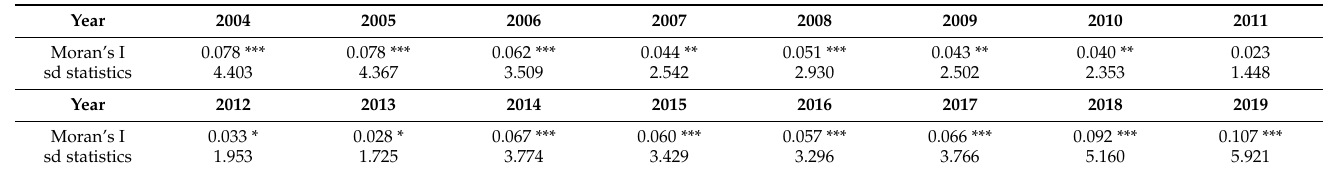
Table 3. Moran’s I change of GUEIL from 2004 to 2019.